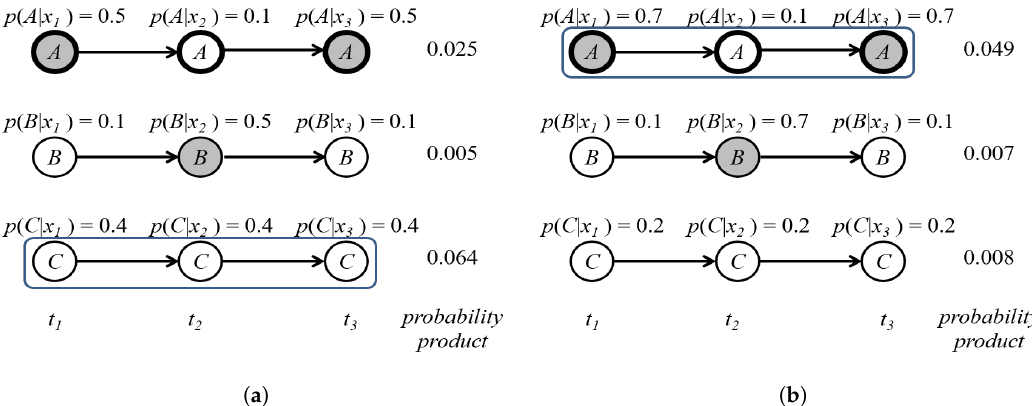
Figure 16. Average F1 score before and after MLCS algorithm. From left to right in each bar-group RFpixel , AEpatch , CNNpatch and FCNpixel repectively.